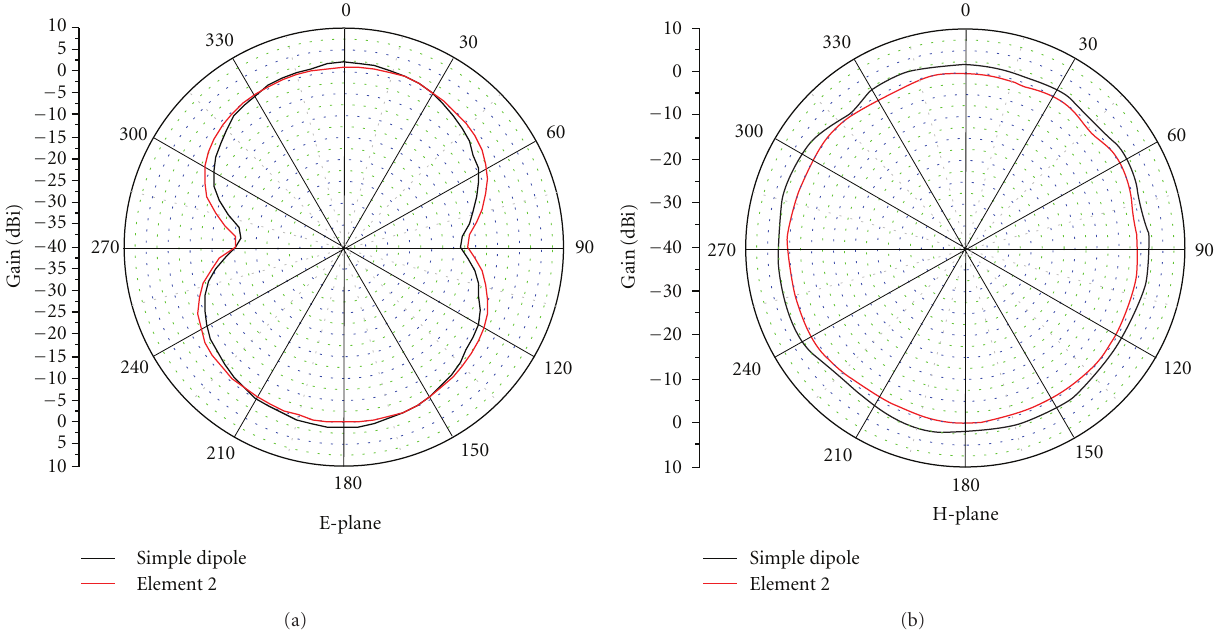
Figure 17: Experimental radiation diagrams of single and element 2 dipoles without reflector plate at